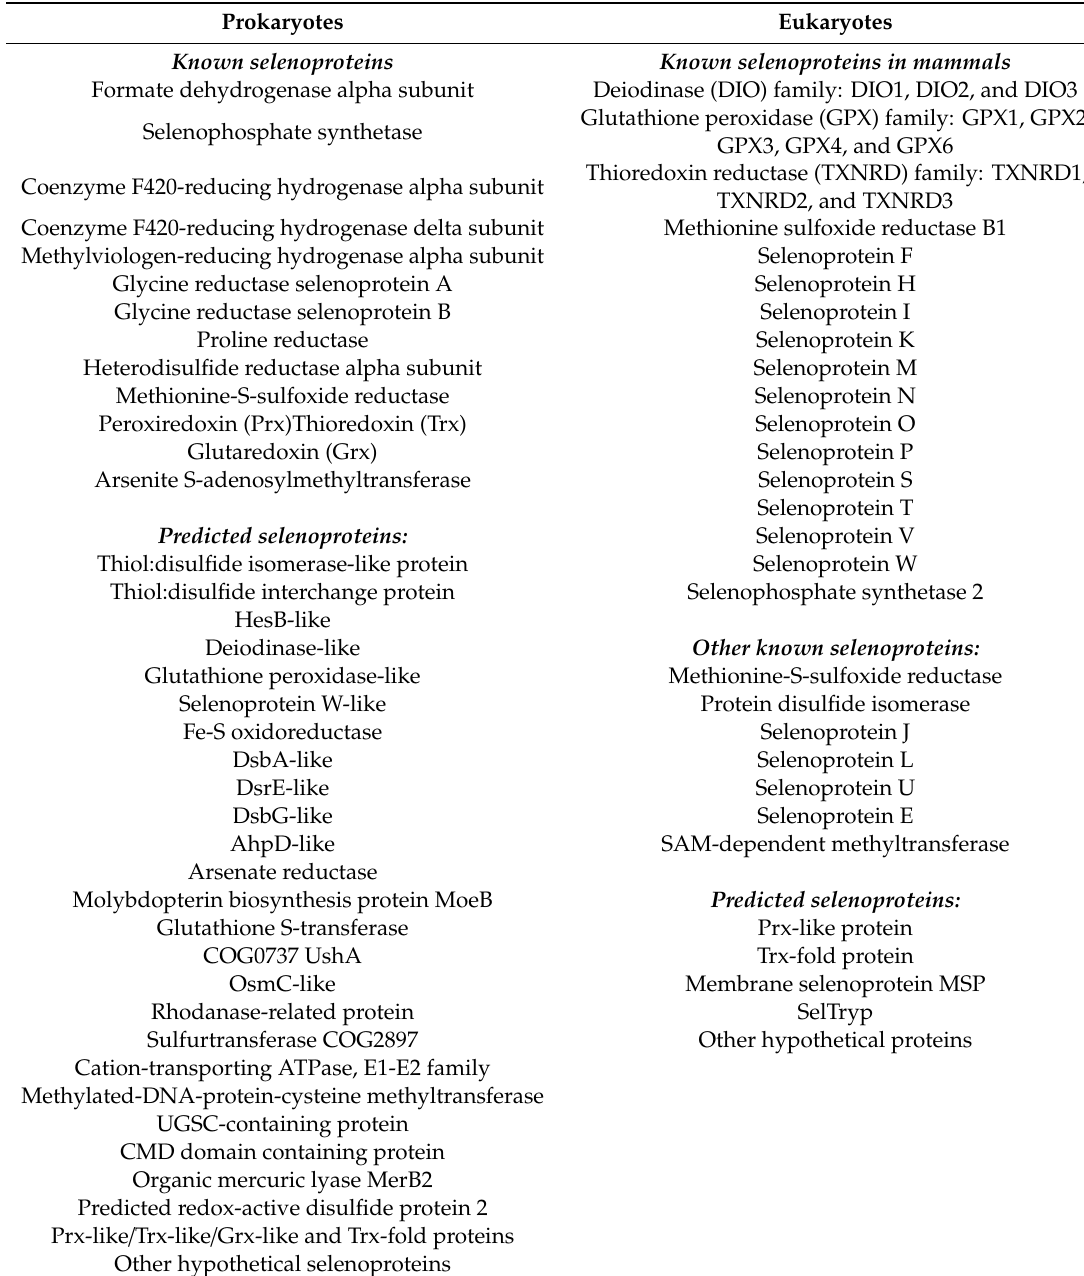
Table 4. List of known selenoprotein families.